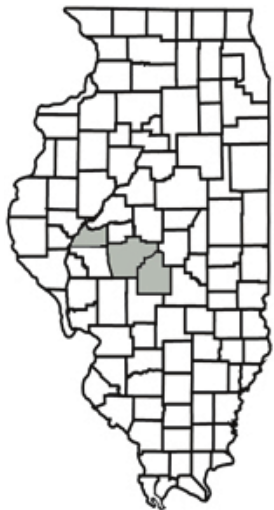
Figure 1. Location of Cass, Sangamon and Christian counties in Illinois, IL, USA.